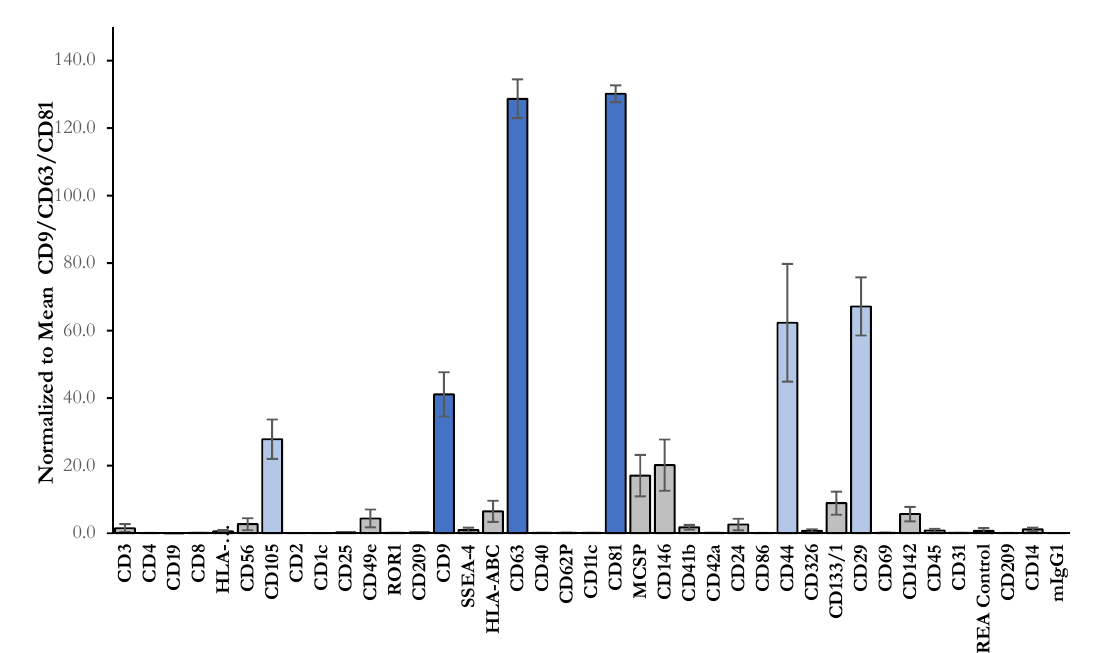
Figure 6. Phenotype of isolated MSCs-CM-derived sEVs by MACSPlex analysis. Data were normalized to mean CD9/CD63/CD81 and displayed in MACSPlex analysis of sEVs ( n = 4) ± SD. Table 1. Detection of MSCs-CM-derived sEVs abundance.